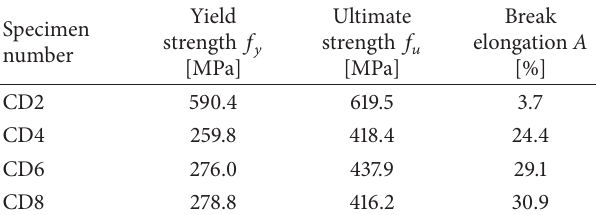
Table 2: Mechanical properties of steel